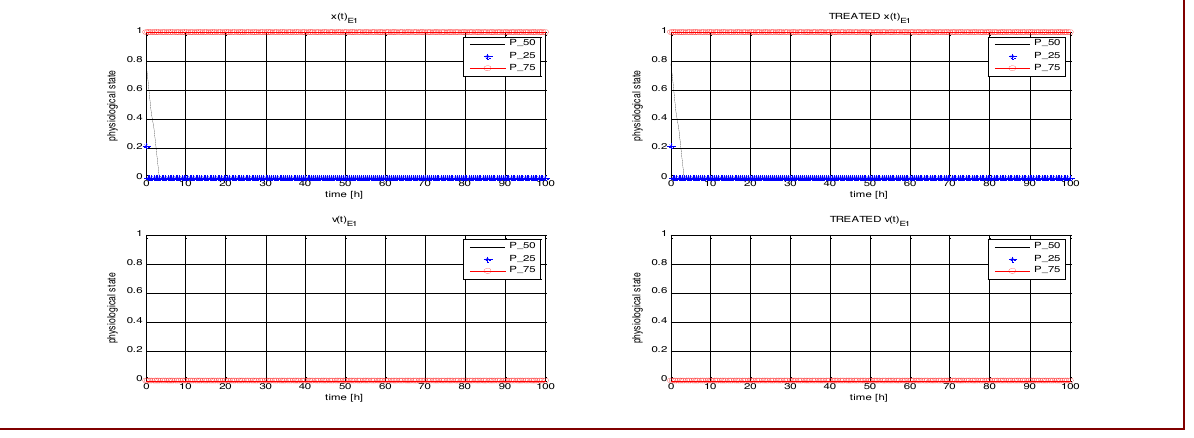
Fig. 6. On the left-hand side, it is shown the evolution of 25°, 50° and 75° percentile UNTREATED patient (x(t) and v(t)) for variable E1; on the right-hand side, it is shown the evolution of 25°, 50° and 75° percentile TREATED (0 2 ) patient (x(t) and v(t)) for variable